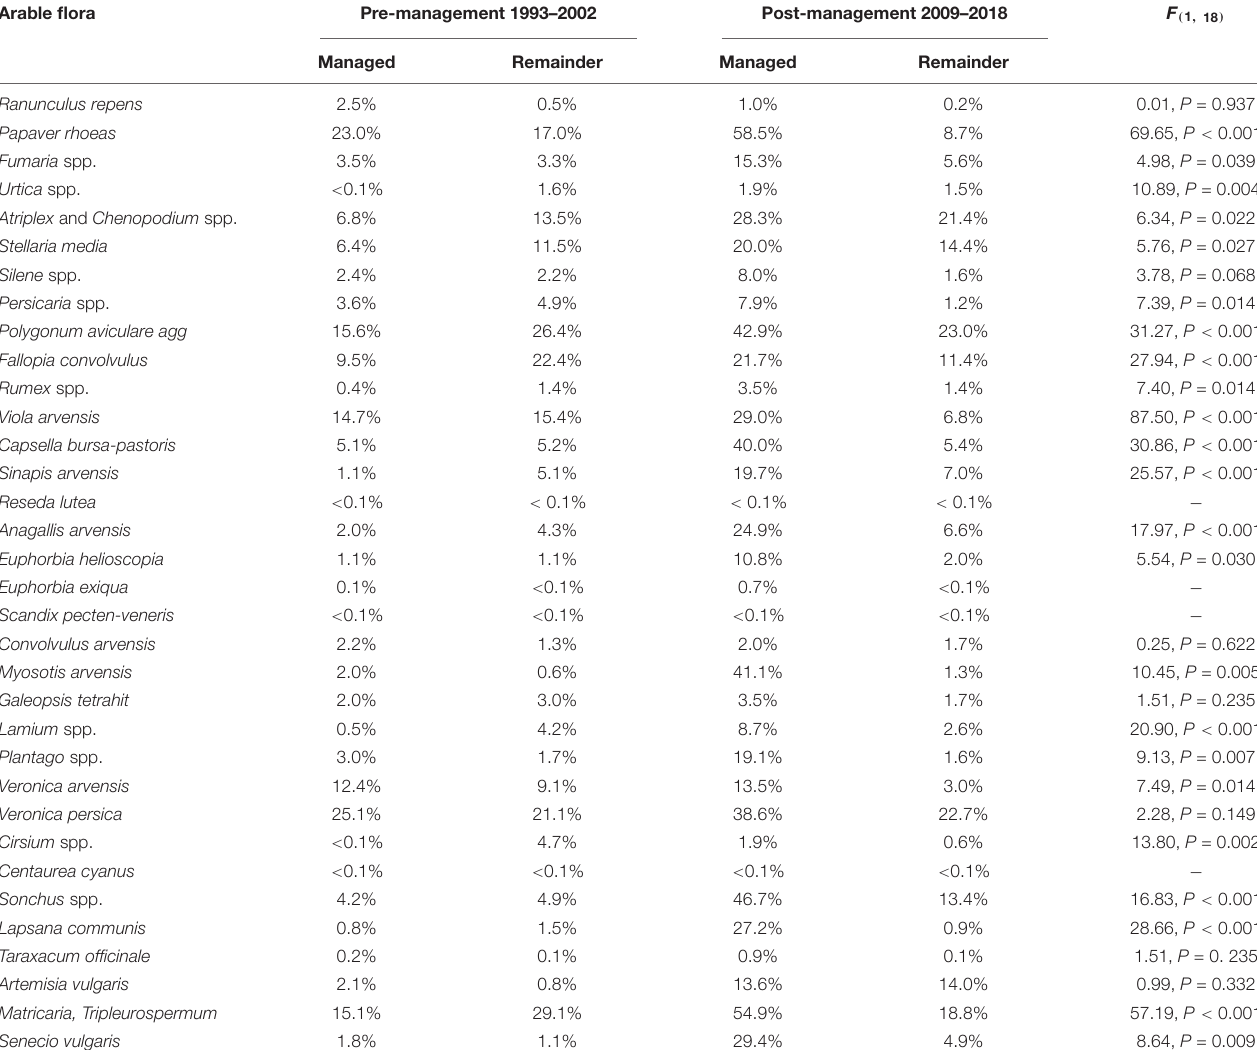
TABLE 1 | Occurrence of arable plant taxa associated with the diet of farmland birds in the area under gray partridge shoot management (managed) and the conventionally managed area of the Sussex Study (remainder), pre- and post-management. Arable